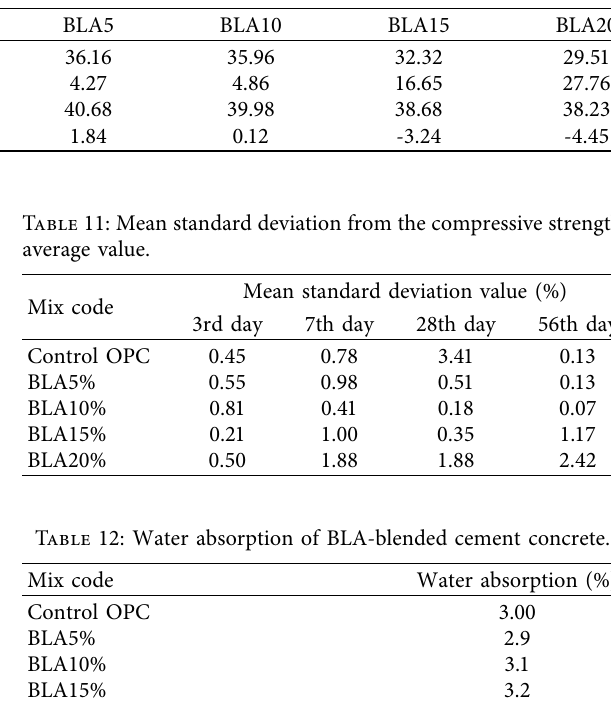
Table 10: Compressive strength reduction and increment value.